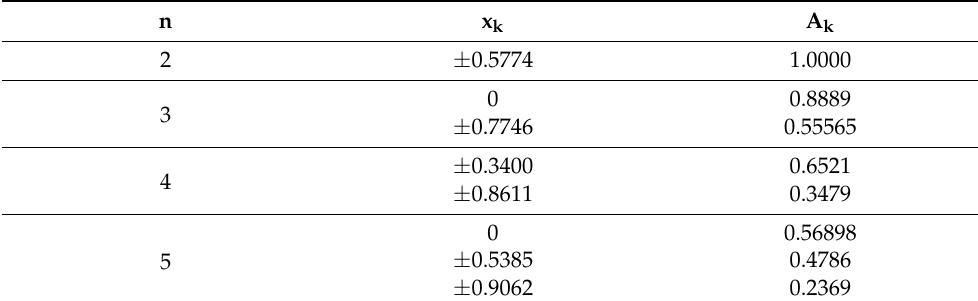
Table 1. Gauss–Legendre quadrature basis points and